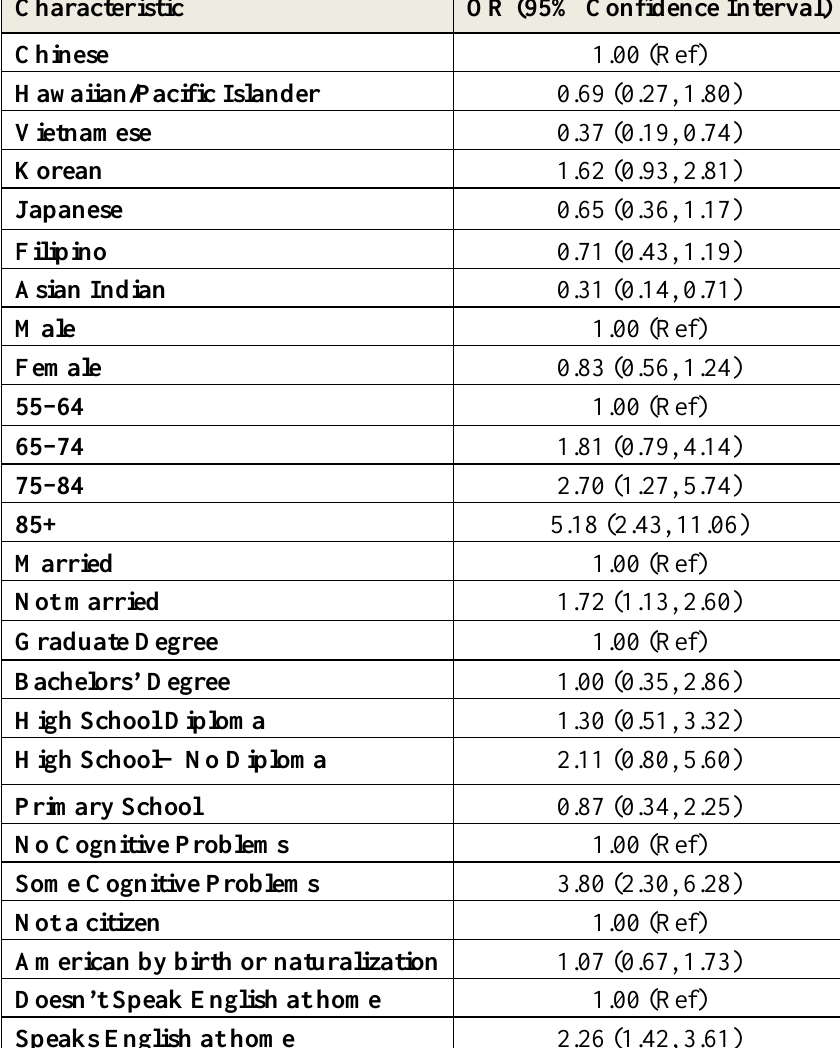
Table 3. Logistic Regression Analysis of Institutionalization among Individuals Aged 55 and over with Limitations in Activities of Daily Living. (Includes 7 AAPI Ethnicities Only, Non-Hispanic Whites Excluded) Source: 2006 American Community